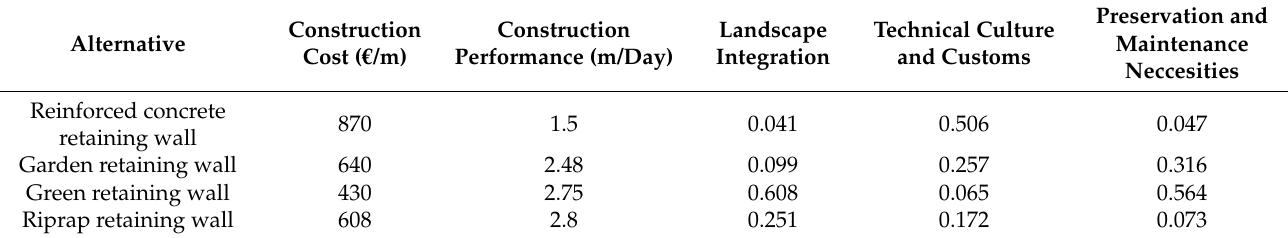
Table 3. Data and values of alternative for each criterion. Source: the authors’ own research.